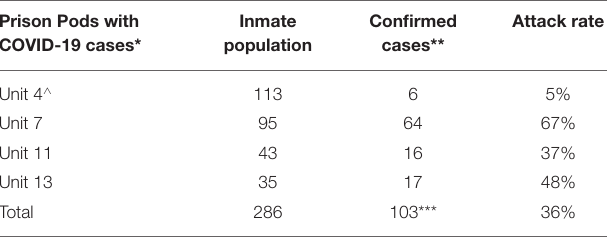
TABLE 1 | Descriptive epidemiology of the COVID-19 outbreak in the CPAII prison in Alicante, Spain (January–April 2021). Prison Pods with COVID-19